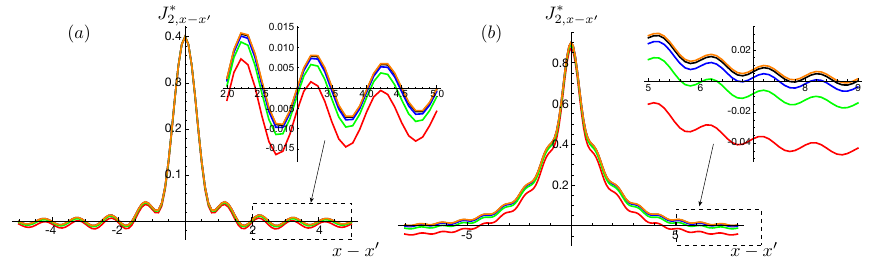
Figure 12: (a) J ∗ in D = 1 plotted as a function of x − x (cid:48) for σ = 2.01 and 2, x − x (cid:48) ζ = − 0.1 for z = 26 at N = e 30 (red), N = e 31 (green), N = e 32 (blue), N = e 33 (black), N = e 34 (orange). (b) The profile at σ = 0.01 and ζ = 0.1. Curves with a same color are the ones with a same N . α is set to